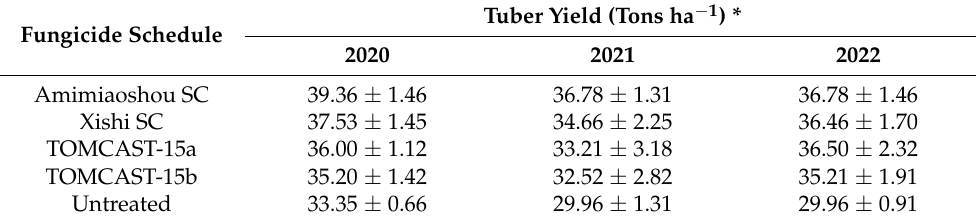
Table 4. Mean tuber yield of different fungicide schedules from 2020 to